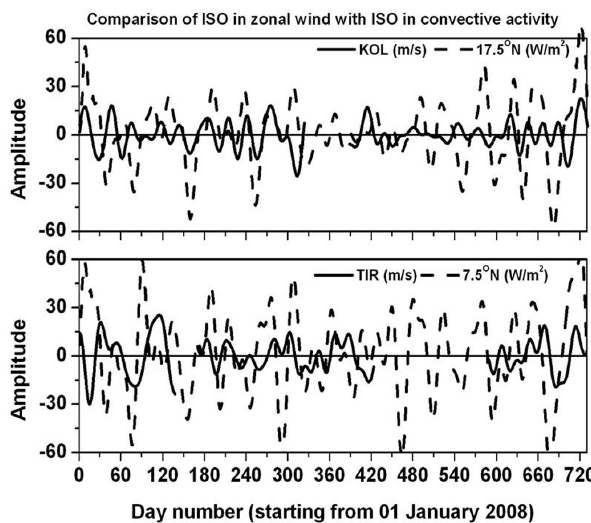
Fig. 9. Bottom panel compares the ISO in OLR at 7.5 ◦ N latitude (averaged over 70 ◦ E–80 ◦ E longitude) with ISO in zonal wind over TIR and top panel compares the ISO in OLR at 7.5 ◦ N latitude (averaged over 70 ◦ E–80 ◦ E longitude) with ISO in zonal wind at 88km over